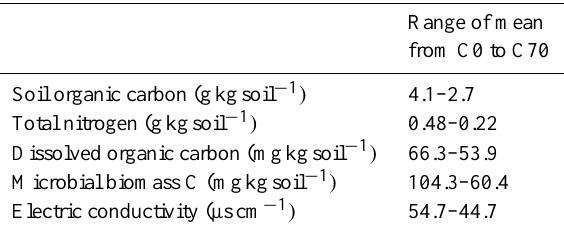
Table 1. Mean and range of soil chemical characteristics for 0– 10cm soil in different soil coarseness degrees from 0% sand ad- dition (C0) to 70%